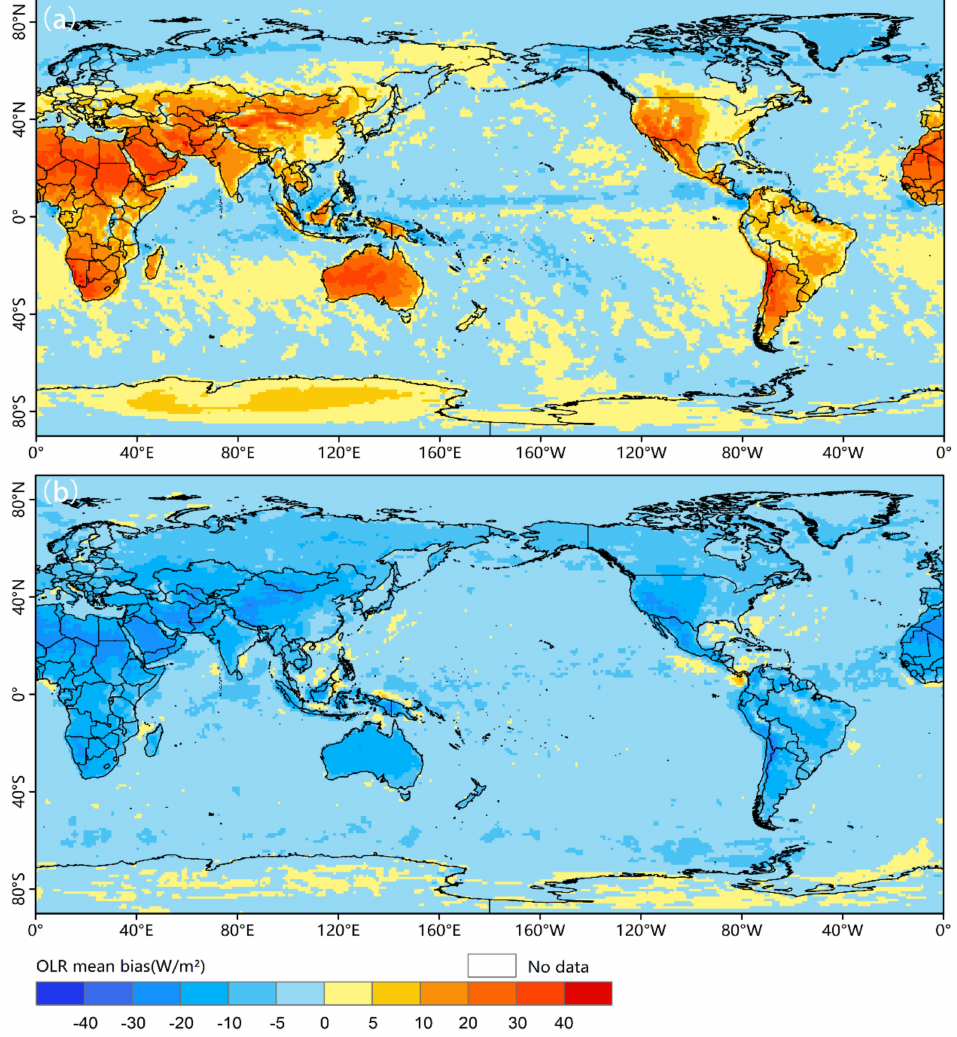
Figure 2. Spatial distributions of the MB between F _OLR and N _OLR in the day ( a ) and night ( b )